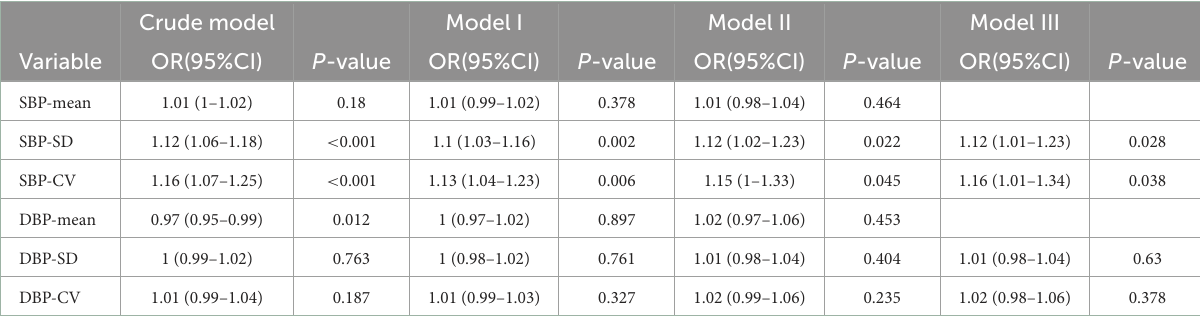
TABLE 2 Relationship between daily blood pressure variability and adverse outcomes within 3 months in different models.